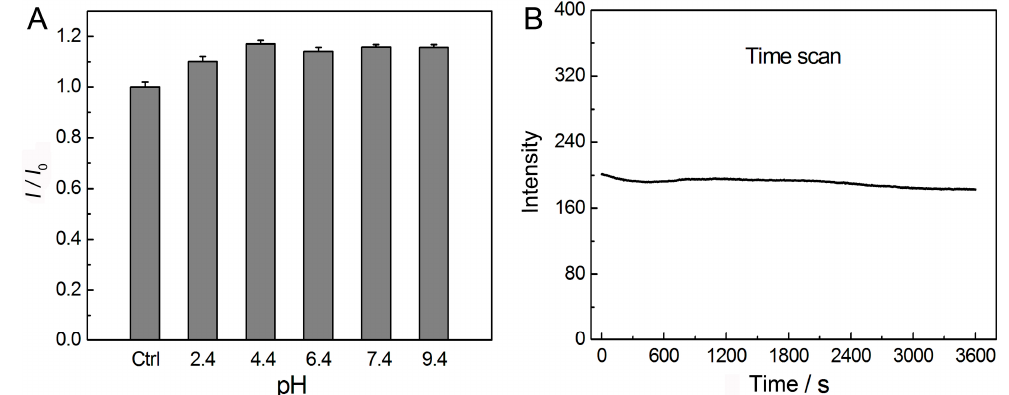
Figure 4. ( A ) Luminescence intensity of the as-prepared AuNCs at different pH. The parameters of I 0 and I represent luminescence intensity of the original AuNCs as prepared and after adjusting the pH, respectively; ( B ) Photostability of the AuNCs under continuous irradiation (excitation wavelength: 370 nm) for 1 h.